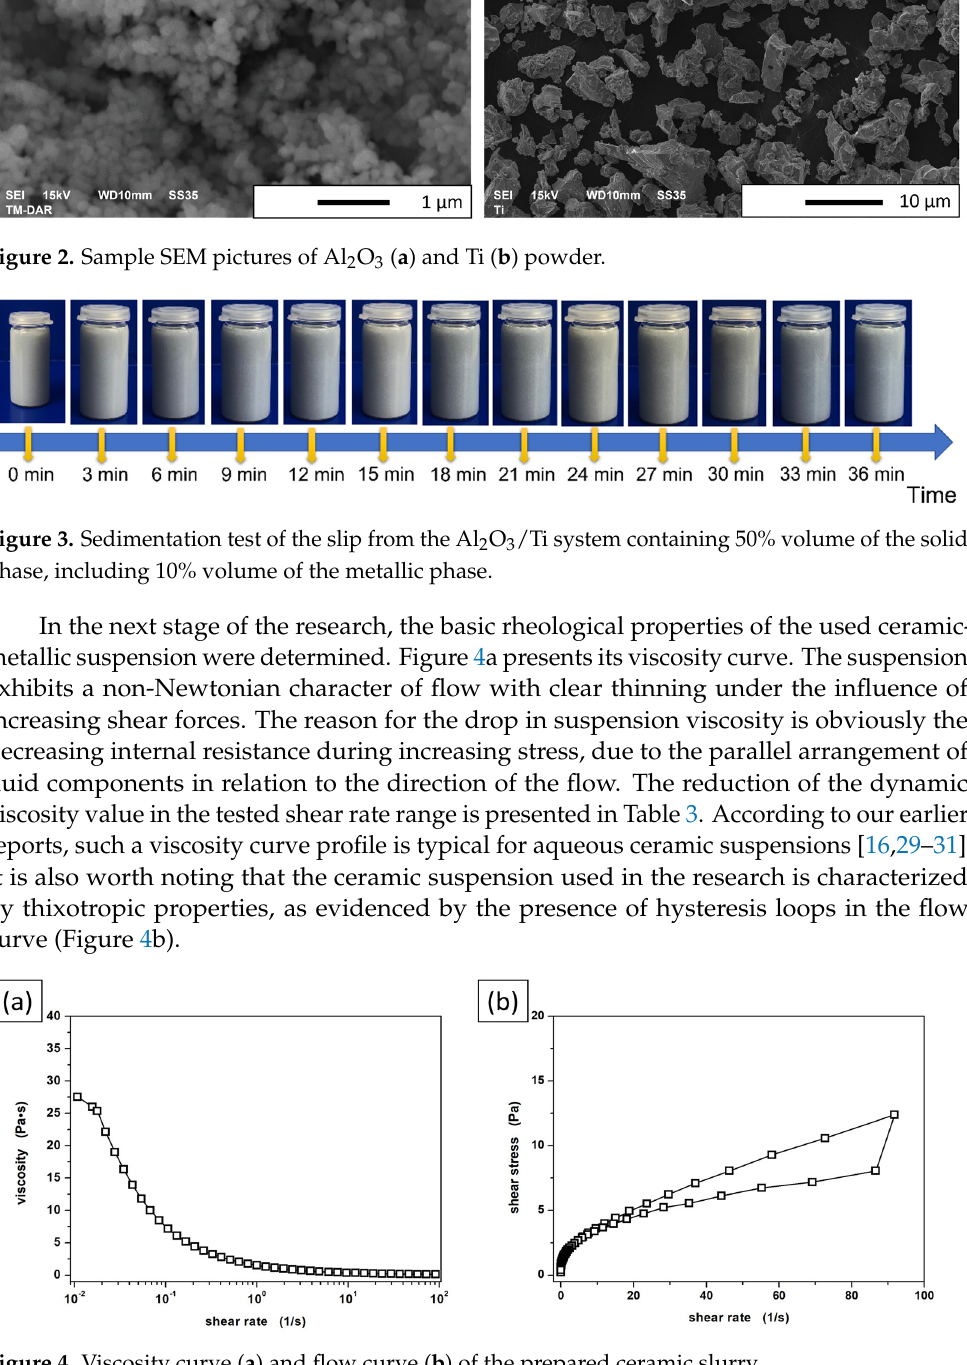
Figure 4. Viscosity curve ( a ) and flow curve ( b ) of the prepared ceramic slurry. Table 3. Value of dynamic viscosity of prepared ceramic slurries for shear rates of 0.1; 1; 10; and 100 s −